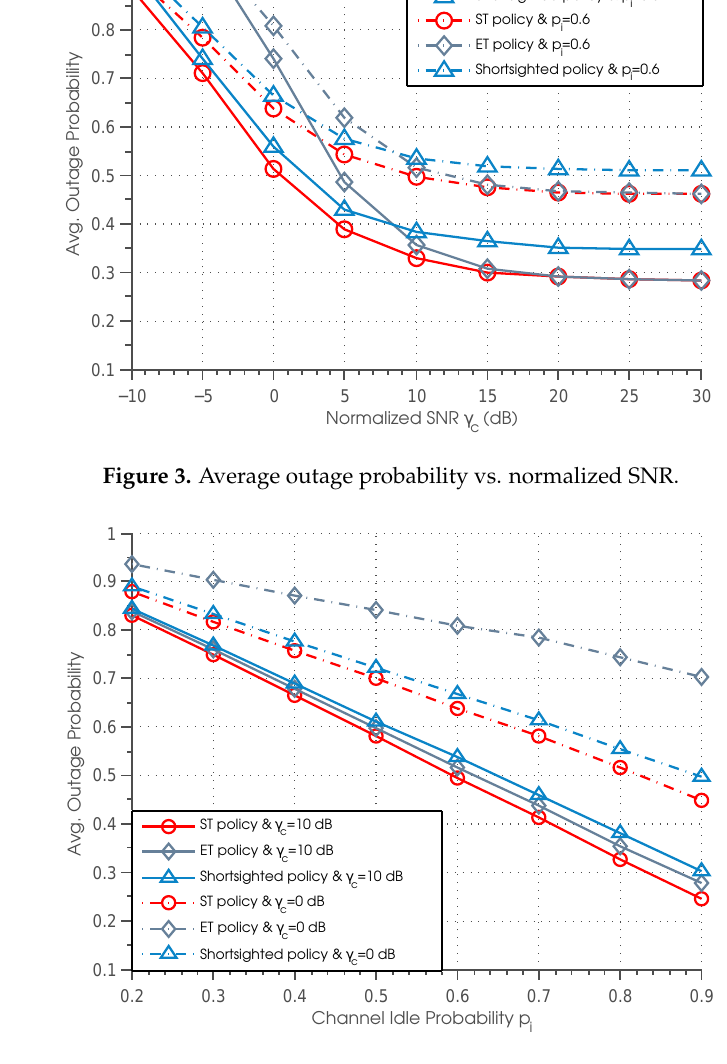
Figure 4. Average outage probability vs. channel idle